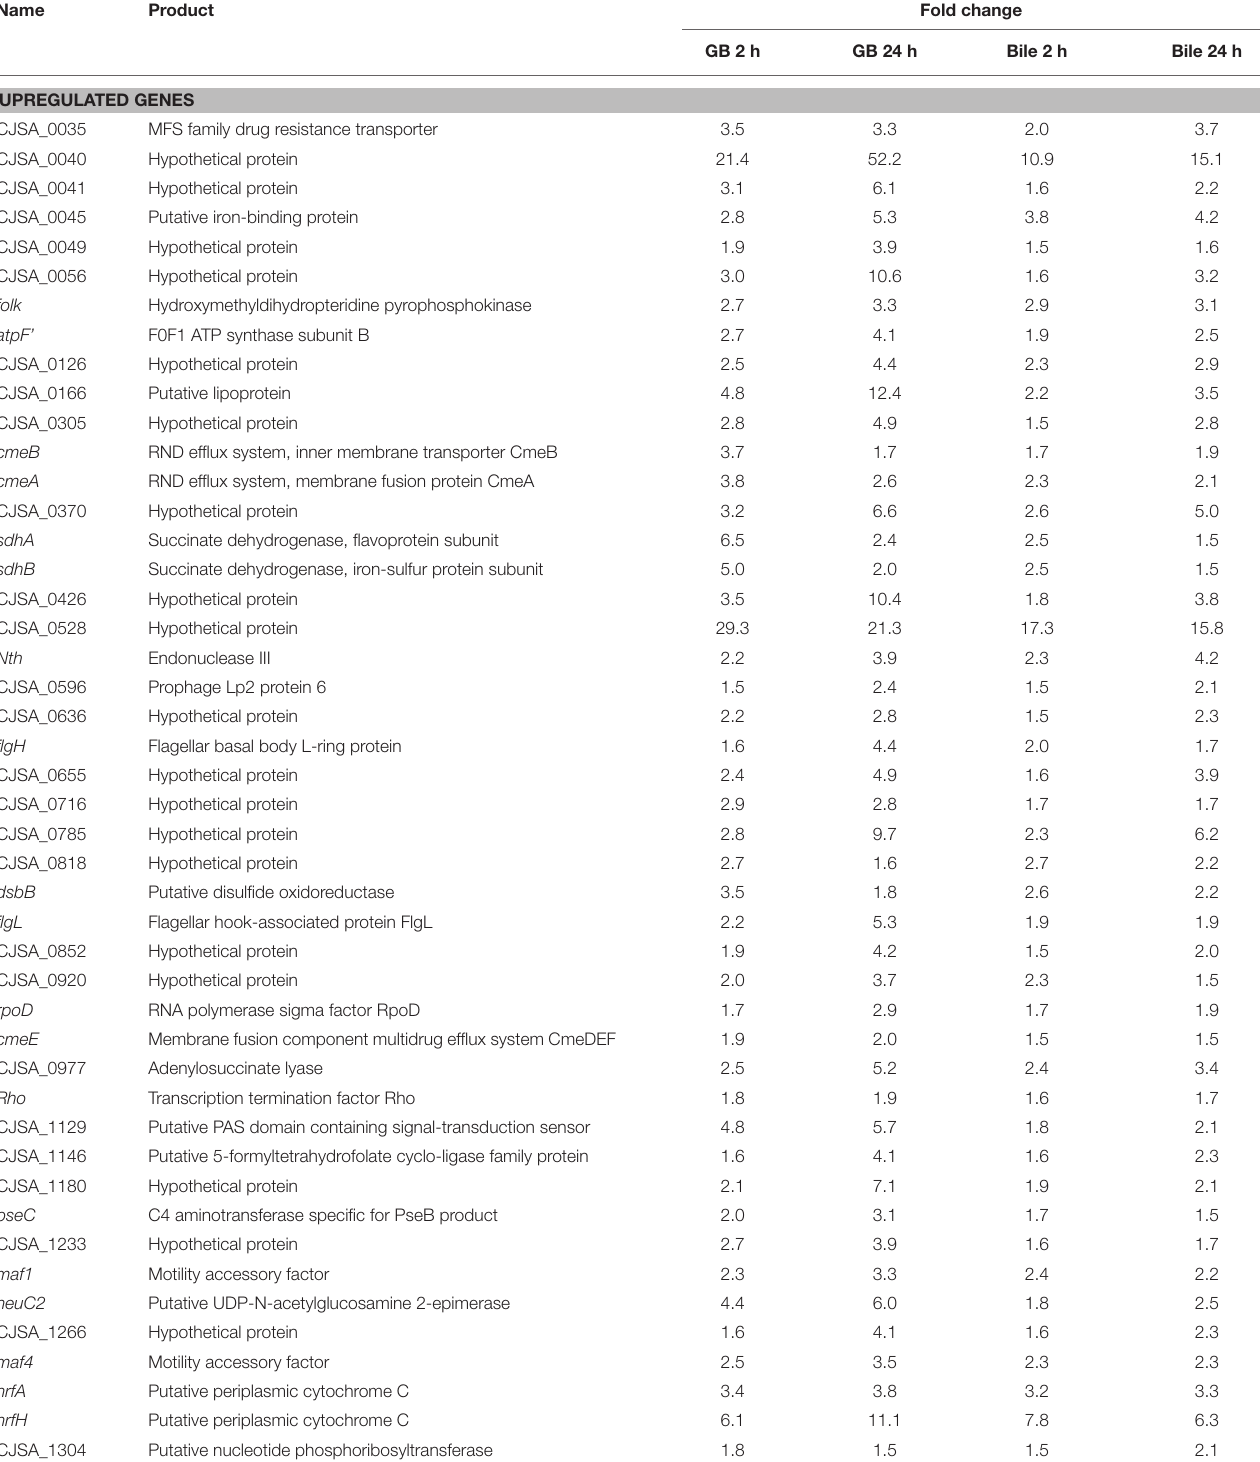
TABLE 2 | List of annotated genes identified to be upregulated or downregulated under all four conditions when compared with the unexposed IA3902